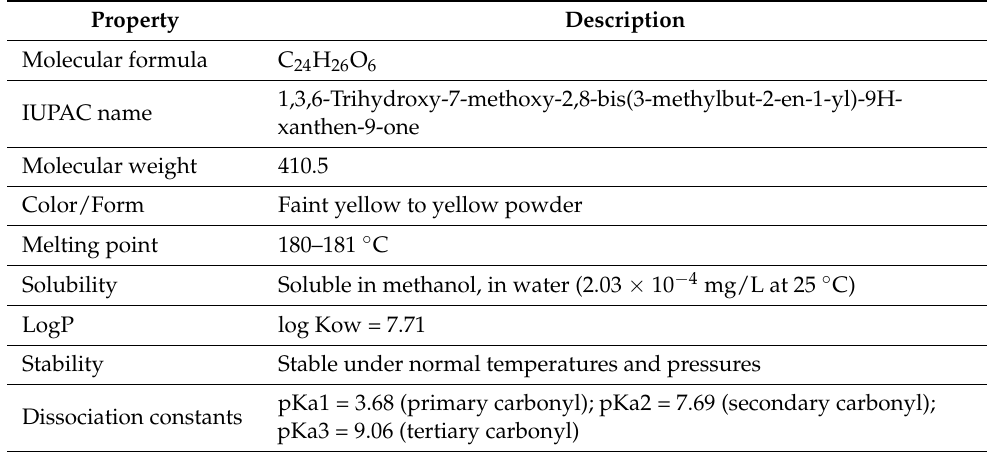
Table 1. The physicochemical properties of α -mangostin